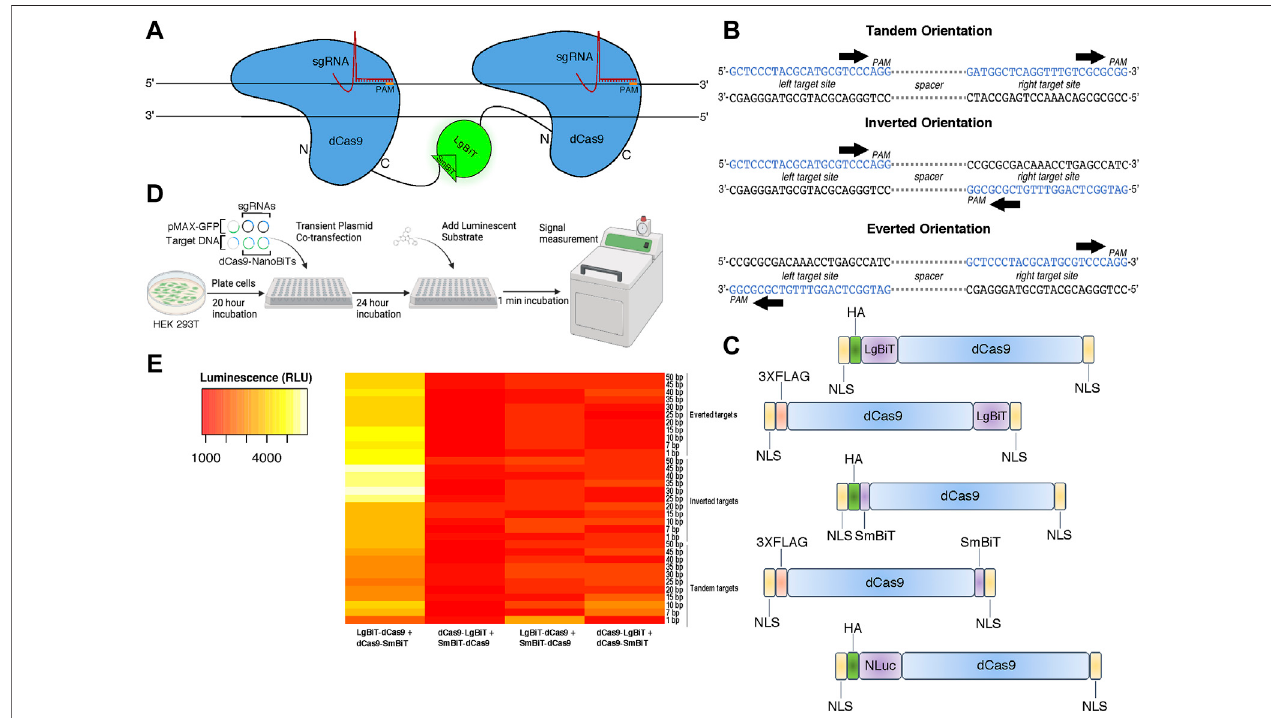
FIGURE1| DesignandcharacterizationofasplitluciferaseDNAbiosensor. (A) Acartoondepictionofsequence-dependentreassemblyofNanoLucluciferase. (B) SchematicoftargetsitedesignswithPAMsitesintandem(parallelonthesamestrand),inverted(PAMsorientedinwardonoppositestrands)andeverted(PAMsoriented outward on opposite strands). (C) Cartoon representation of dCas9-NanoBiT and full-length dCas9-NanoLuc fusion constructs. (D) Depiction of experimental process forinitial luminometer-basedDNAbiosensingassayslabelingallco-transfected plasmids. (E) Aheatmap showingvariationinluminescentsignalintensitybetween four possible orientationsof dCas9-NanoBiTfusion proteins across 33DNA target site spacings and orientations. Sequential scale ranges from lowest signals ofthe set (red) to highest signals of the set